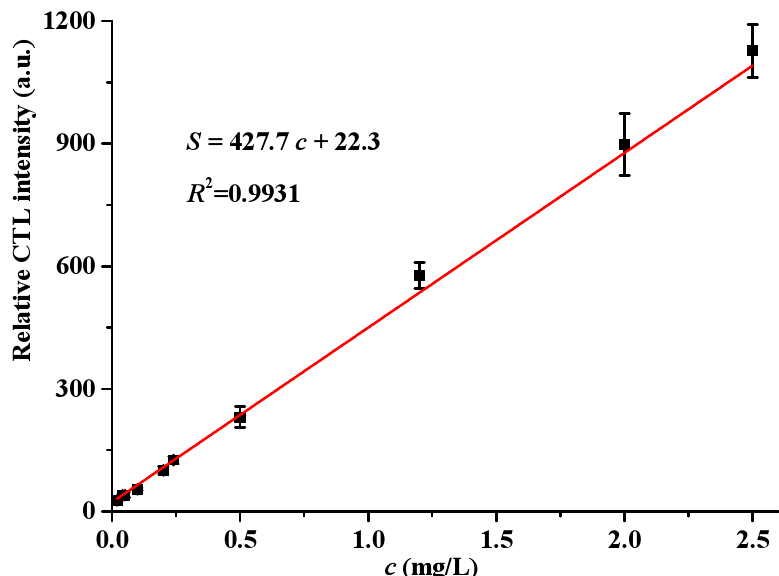
Figure 6. The calibration curve between the relative CTL intensity and the concentration of acetaldehyde. Test conditions were: air flow rate: 80 mL/min, temperature: 200 °C, wavelength: 425 nm. Error bars stand for ± S.D. Table 1. Comparison of performances of acetaldehyde gas sensors.